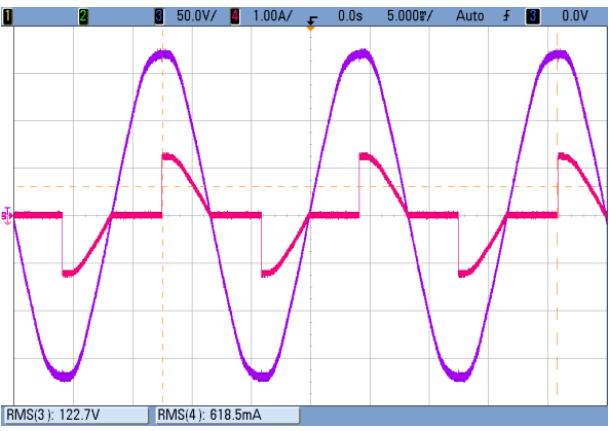
Figure 8. Voltage and current waveforms at the rectifier